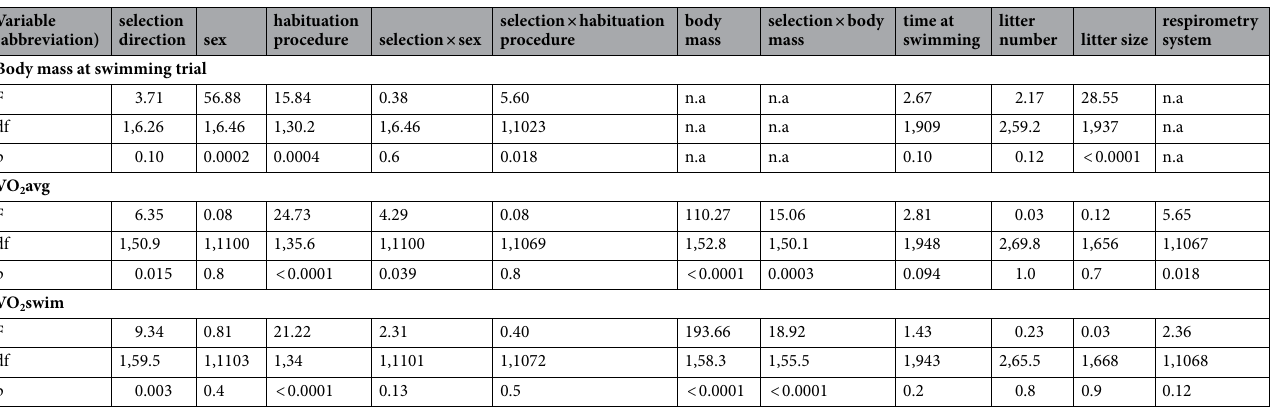
Table 2. Results of ANCOVA models performed on data from all animals which underwent a swimming trial in generation 25, either as a part of selection protocol or following a habituation procedure for the chronic stress experiment. Significance of fixed factors, covariates and interactions on body mass measured at the trial, and measures of swimming metabolism: average oxygen consumption (VO 2 avg) and maximum 1-min oxygen consumption (VO 2 swim). n.a. – non-applicable (factor absent from the model).